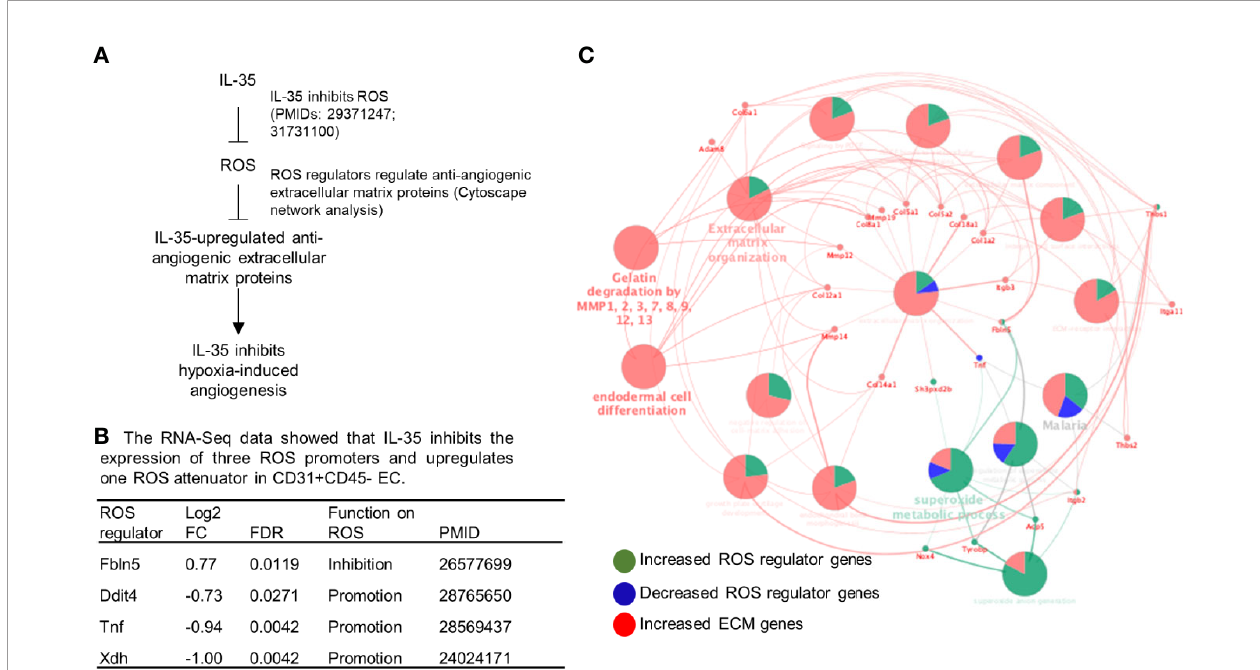
FIGURE 6 | IL-35 inhibits the expression of reactive oxygen species (ROS) regulators including downregulation of ROS promoters such as Ddit4, TNF and Xdh and upregulation of ROS attenuator fi bulin-5 (Fbln5), which are connected to downstream extracellular matrix proteins, revealed by Cytoscape analysis. (A) A schematic presentation of IL-35 inhibition of reactive oxygen species generation and IL-35 upregulation of anti-angiogenic extracellular matrix proteins. Of note, we have two publications that clearly indicate IL-35 inhibition of ROS generation (the PMIDs included). (B) Our RNA-Seq data analysis indicated that IL-35 downregulates three ROS promoter genes including DNA damage inducible transcript 4 (Ddit4, REDD1, HIF-1 responsive RTP801), tumor necrosis factor-a (TNF), and xanthine dehydrogenase (Xdh, XOR) and upregulates ROS inhibitor fi bulin-5 (Fbln5) in CD45-CD31+ endothelial cells (EC) treated with IL-35 versus PBS-treated controls with the criteria offalse discovery rate (FDR) < 0.05. The regulatory functions of these four ROS regulators were reported and the PMIDs were included. Of note, the expression of 165 ROS regulators were examined in the Gene Set Enrichment Analysis (GSEA, https://www.gsea-msigdb.org/gsea/msigdb/cards/GO_REACTIVE_OXYGEN_SPECIES_ METABOLIC_PROCESS). (C) The network data integration database Cytoscape analysis (https://cytoscape.org/) was used to analyze the network connection between ROS regulators and anti-angiogenic extracellular matrix proteins. The small dots were the ROS regulator genes and extracellular matrix genes that IL-35 regulated. The large dots were extracellular matrix protein pathways. The bright words, but not dim words, indicated the signi fi cance of the